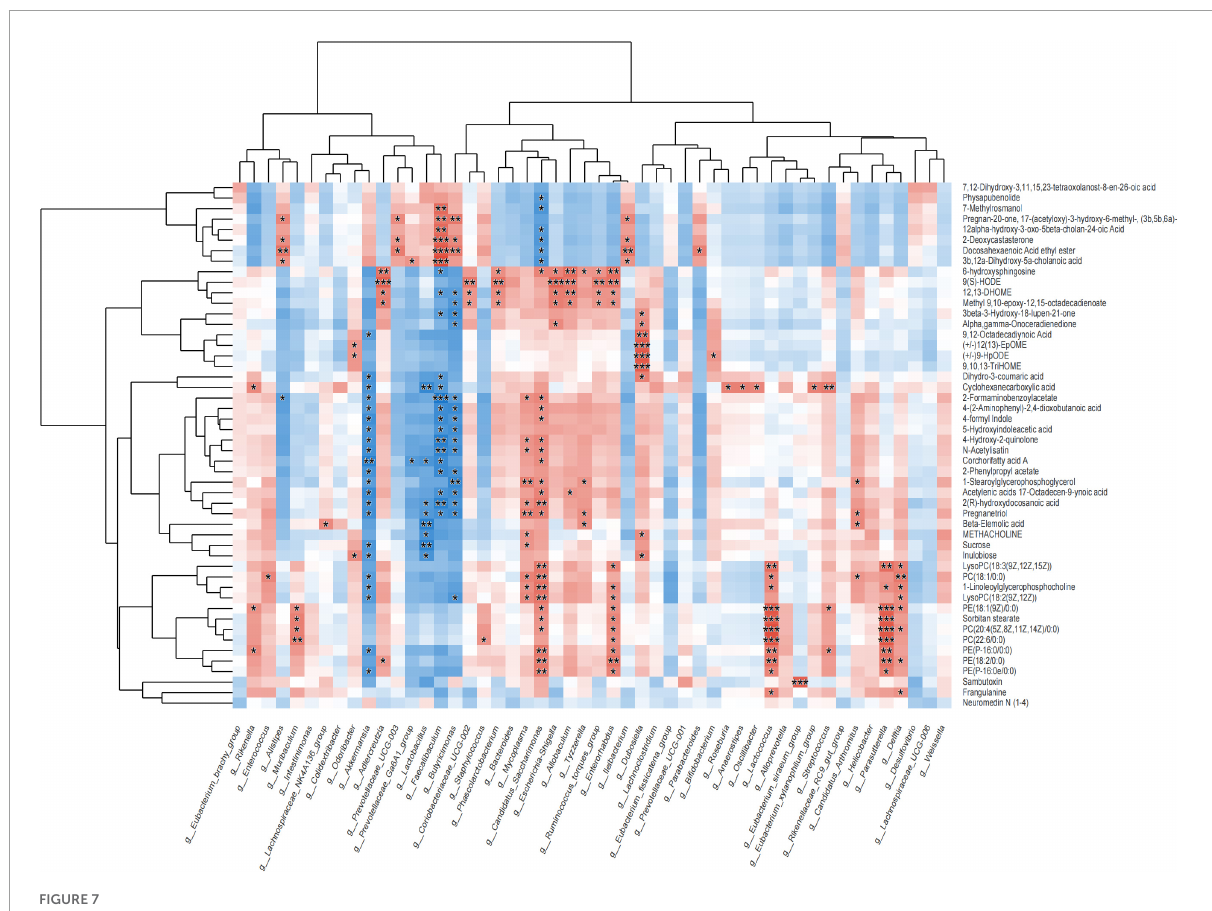
FIGURE7 Correlation between metabolics and 16S microbiome